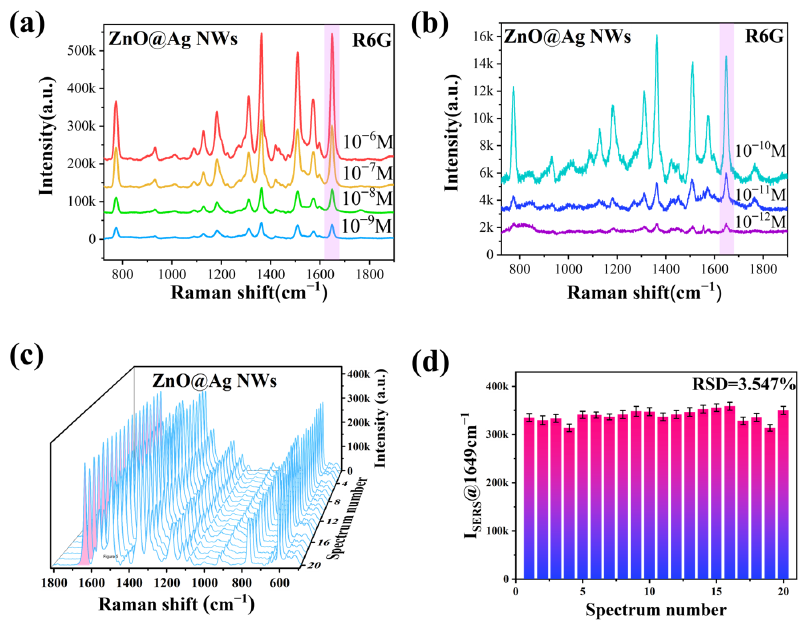
Figure 5. SERS spectra of R6G at a concentration of 10 −6 to 10 −9 M ( a ) and 10 −10 to 10 −12 M ( b ). SERS spectra ( c ) and uniformity ( d ) of 10 −6 M R6G on ZnO NPs@Ag NWs at 20 random positions. Good stability is necessary for the practical application of SERS substrates. The SERS intensity of pure Ag NWs decreased to 34% of the initial intensity at 1649 cm −1 in the ambient environment for 30 days (Figure 6a,b). In contrast, ZnO NPs@Ag NWs substrates remained at more than 90% of the initial intensity (Figure 6c,d). This indicates that ZnO NPs@Ag NWs have superior long-term stability compared to Ag NWs, which may be due to the reduced substrates’ air oxidation by the modified ZnO nanoparticles [70,71].